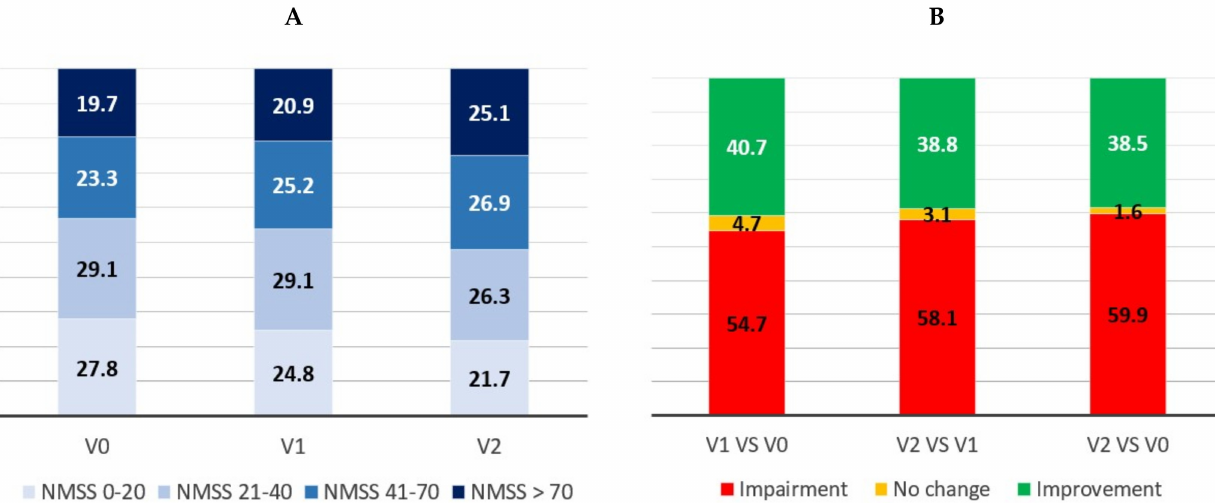
Figure 2. ( A ) Percentage of PD patients with mild (NMSS 1–20), moderate (NMSS 21–40), severe (NMSS 41–70), and very severe (NMSS >70) NMS burden at V0 (baseline), V1 (1 year follow-up ± 1 month), and V2 (2-year follow-up ± 1 month). V1 vs. V0, p < 0.016 (N = 600); V2 vs. V1, p = 0.007 (N = 482), All groups; p < 0.0001 (N = 481). ( B ) Percentage of patients with a greater NMS burden (NMS burden impairment; in red), no change (No changes in the NMSS total score), and a lower NMS burden (NMS burden improvement; in green) at V1 compared to V0, V2 compared to V1, and V2 compared to V0. NMSS, Non-Motor Symptoms Scale.